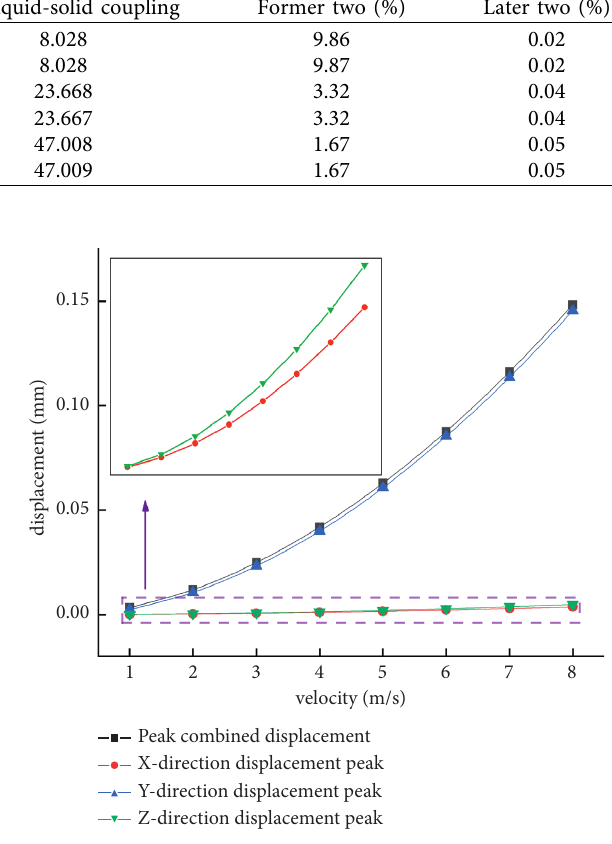
Figure 6: Variation curve of displacement peak in different di- rections with drilling fluid